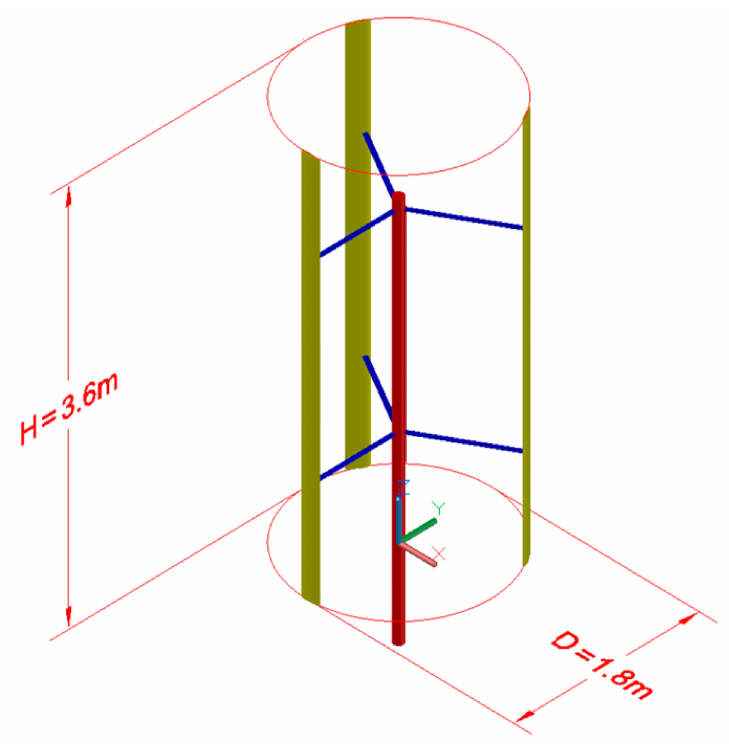
Figure 4. Three-dimensional geometry model of the optimized VAWT.